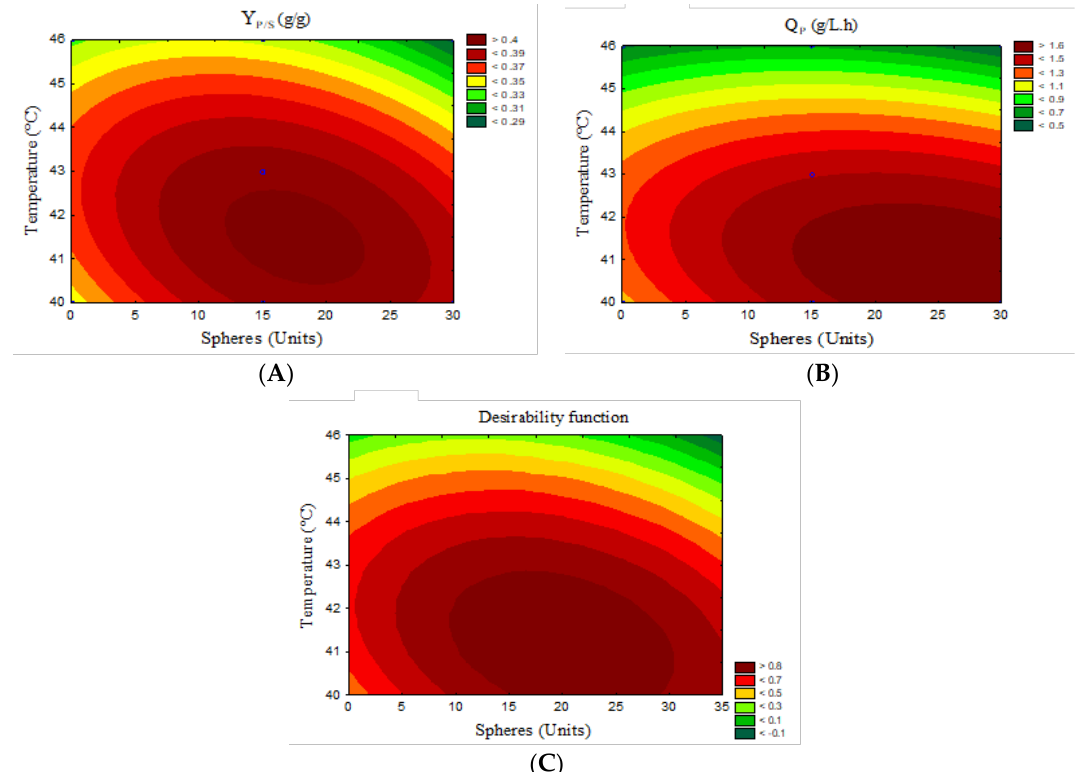
Figure 2. Responses surfaces described by the quadratic models representing the ethanol volumetric productivity ( A ), ethanol yield ( B ) and the optimized region ( C ) as a function of the number of spheres (X 1 ) and temperature (X 2 ) from SSF experiments of pre-treated rice straw in the VBM